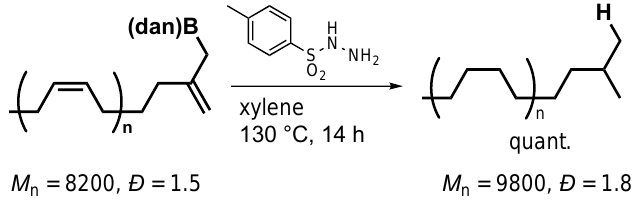
Figure 2. The 1 H NMR spectrum of butadiene/ 2a copolymer obtained in Table 1, run 5 (500 MHz, in CDCl 3